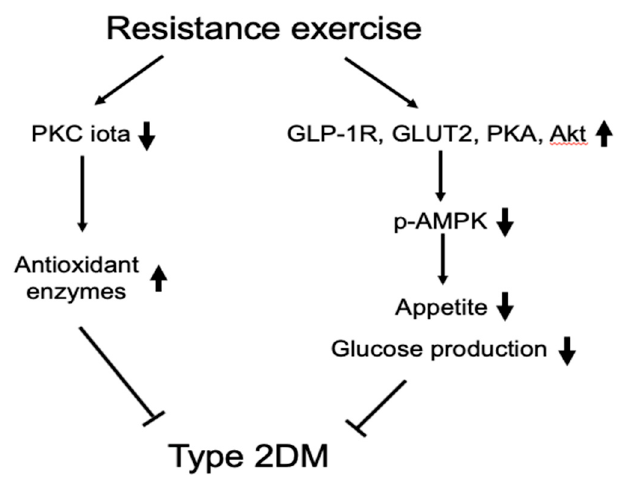
Figure 6. Schematic diagram of the mechanisms for the resistance exercise in hypothalamus of type 2 diabetic rats.